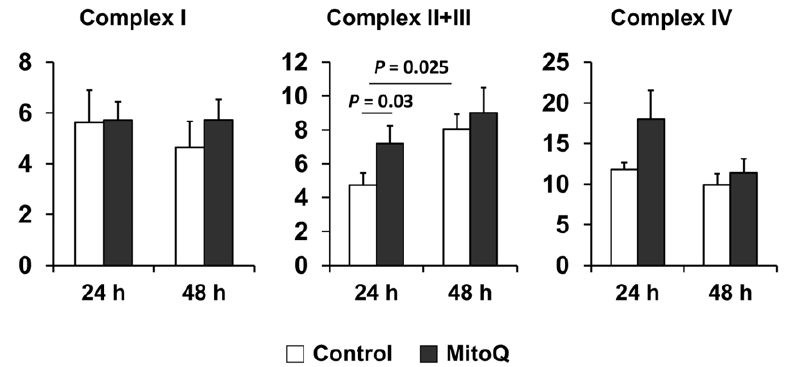
Figure 3. MitoQ improves electron transport chain function during cold storage. Respiration status of complex I, II + III, and IV of the ETC evaluated using SIT protocol (see methods). The graph shows mitochondrial complex respiration (measured as oxygen flux) of fresh renal biopsies that were cold stored with or without MitoQ. Error bar indicates Mean 6 S.E.M. (n=5 for both groups). MitoQ significantly improved complex II + III respiration at 24 h time point (P=0.03). Cold preservation (without MitoQ) also improved complex II + III respiration after 48 h (P=0.025).